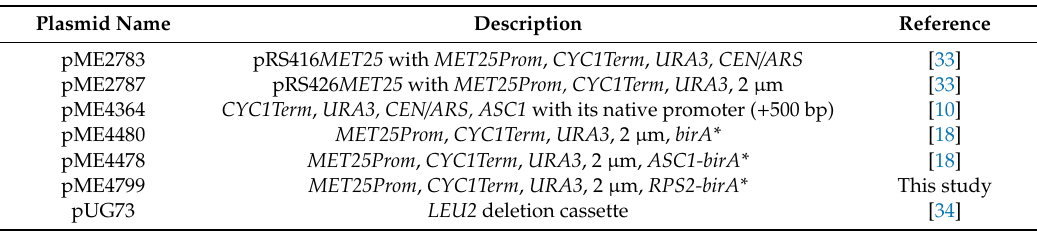
Table 1. Plasmids used in this study.